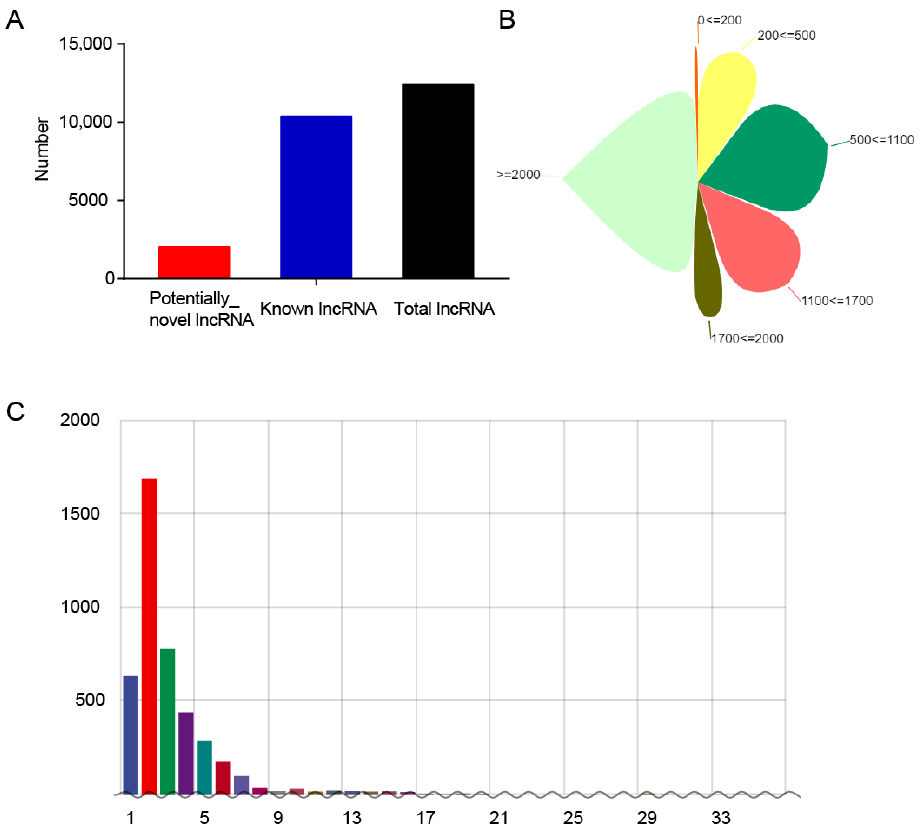
Figure 2. Statistics of lncRNAs: ( A ) number of lncRNA transcripts in spleen tissue (known and potentially novel); ( B ) length distribution; ( C ) exon number.